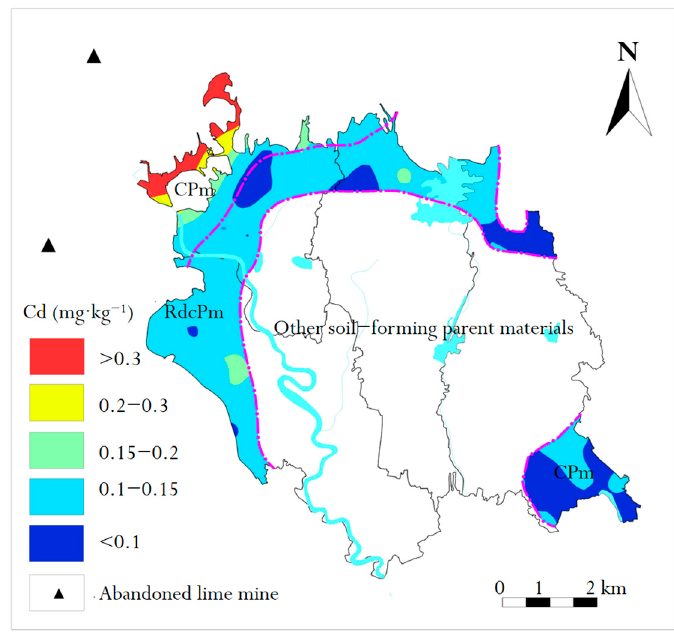
Figure 7. Spatial distribution of Cd in two soil parent materials.